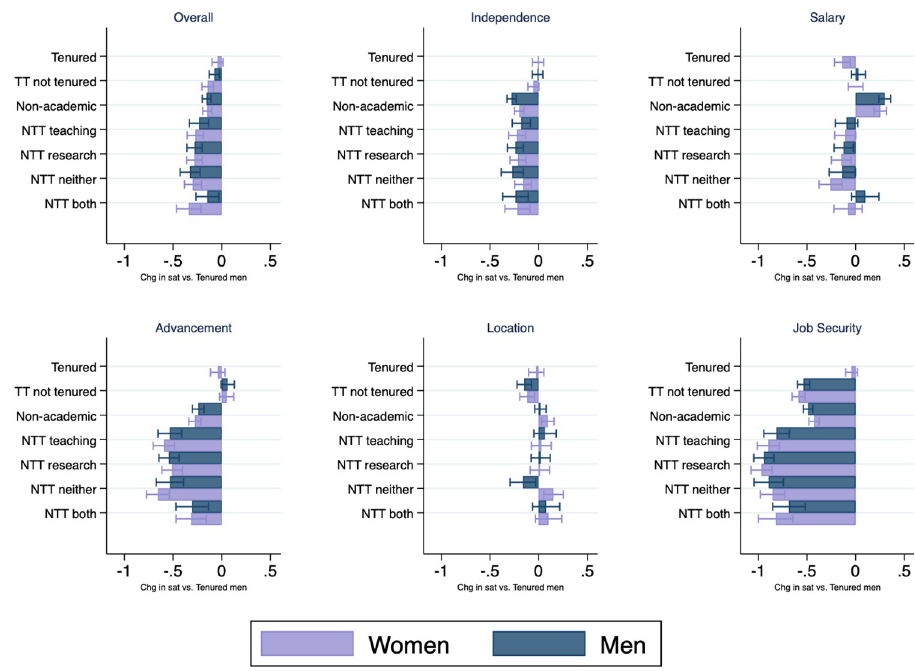
Fig 2. Difference in job satisfaction for various job types 7–9 years after receipt of PhD, relative to tenured men. Notes : Regression coefficients from a regression of job satisfaction overall (A) or with satisfaction with the specific job component listed in the subtitle (B–F) on indicators for the job types and genders as shown in the figures, as well as field of study and years since degree. Omitted category of job type and gender is tenured men, who have the highest overall job satisfaction. Analyses based on data from the National Survey of Earned Doctorates and National Survey of Doctoral